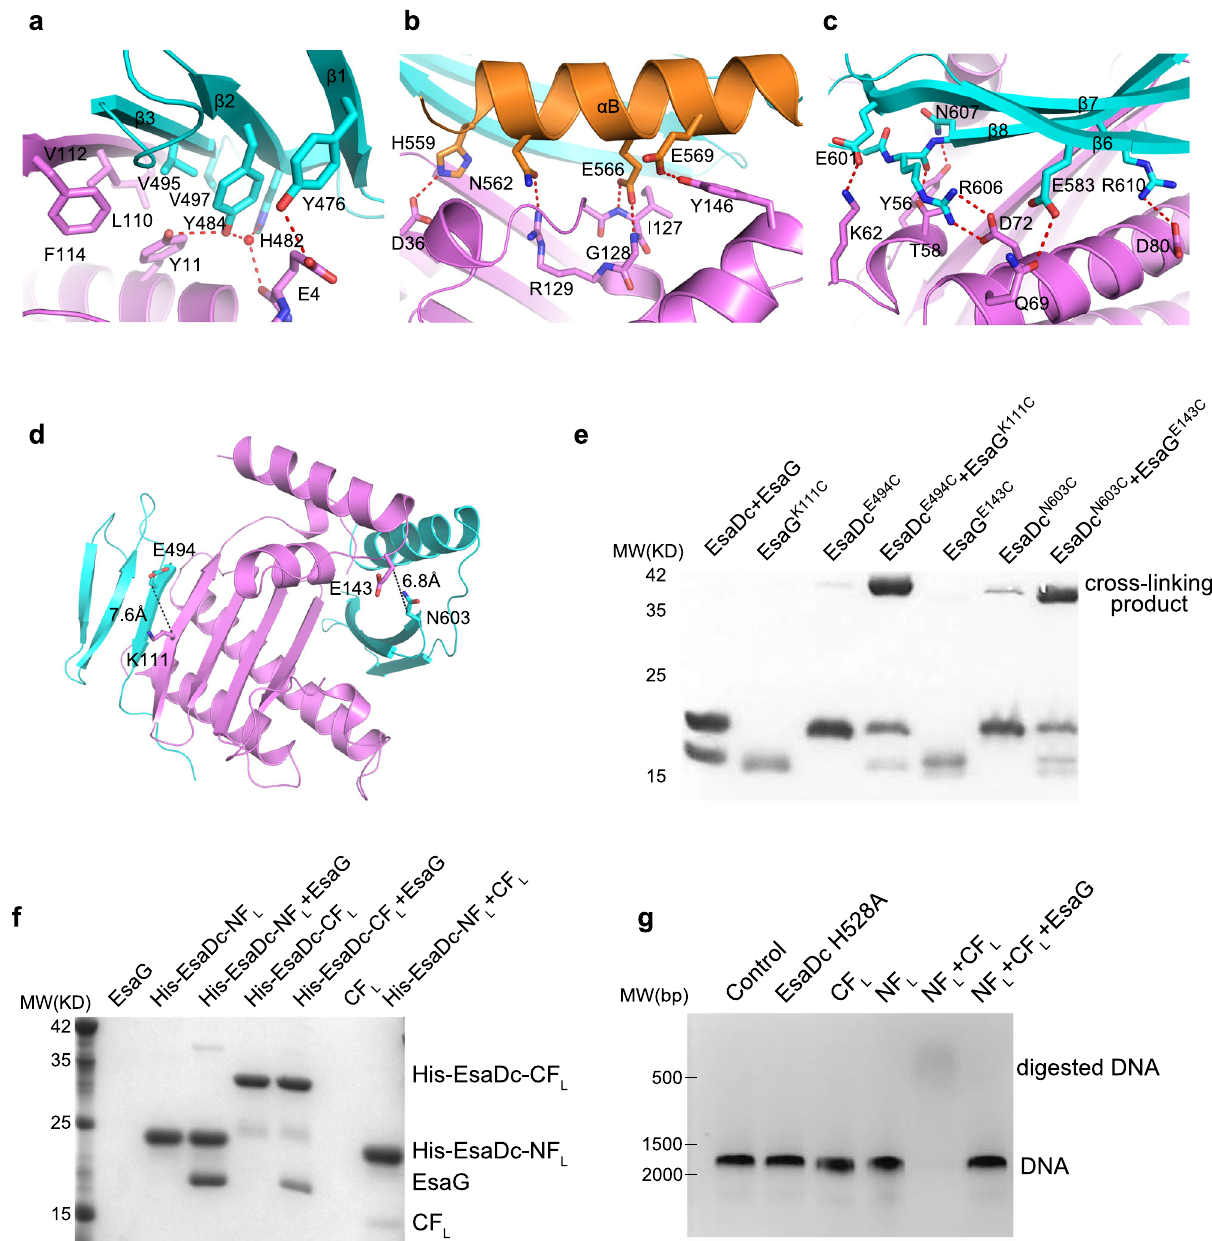
Fig. 2 | The interactions between EsaDc and EsaG. a – c Close-up view of the NF – EsaG ( a ), α B – EsaG ( b ) and the β -sheet (in CF) – EsaG ( c ) interactions. The pro- teins are colored in the same scheme as shown in Fig. 1a. The side chains of the interface residues are labeled and shown as sticks. The hydrogen bonds are depicted as red dashed lines, and the water molecules are shown as red spheres. d Pairsselectedforcross-linkingassay.EsaG K111 andEsaDc E494 areselectedontheNF- EsaG interface. The closest distance between C β of EsaG K111 and EsaDc E494 is 7.6 Ǻ ; EsaG E143 and EsaDc N603 are selected close to the CF-EsaG interface. The closest dis- tancebetweentheatomsonthesidechainsofEsaG E143 andEsaDc N603 is6.8 Ǻ . e SDS-